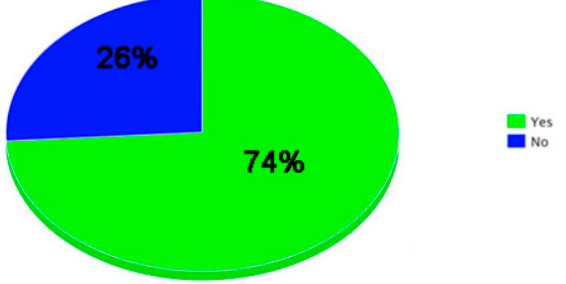
Figure 7. Level of satisfaction of young people with their school.